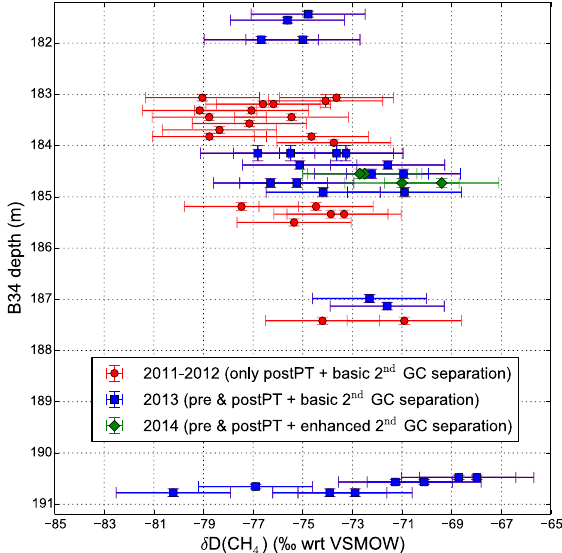
Figure 4. δ D(CH 4 ) of B34 ice core samples measured during the years 2011 to 2014 (using the different set-ups shown in Table 1 and Fig. 1) on a depth scale. Error bars represent the pooled standard de- viation of B34 replicates (2.3‰) for δ D(CH 4 ) and the total depth range of each individual sample. The 10 m depth interval presented here corresponds to an age range of approximately 150 a; accord- ingly, a depth change of 1m represents a nominal age increase of about 15a, which is significantly smaller than the width of the age distribution of the bubbles in the